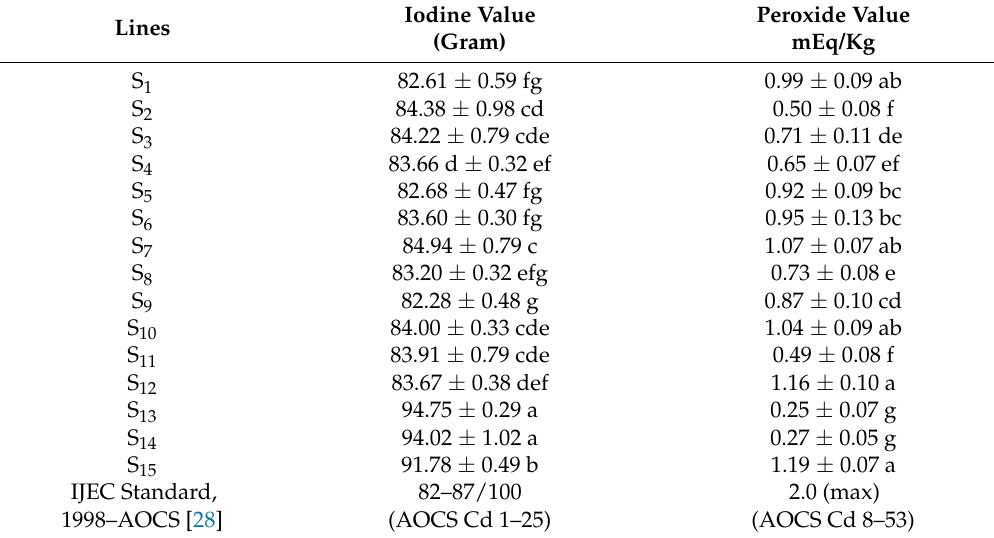
Table 2. Peroxide and iodine values of elite jojoba lines.